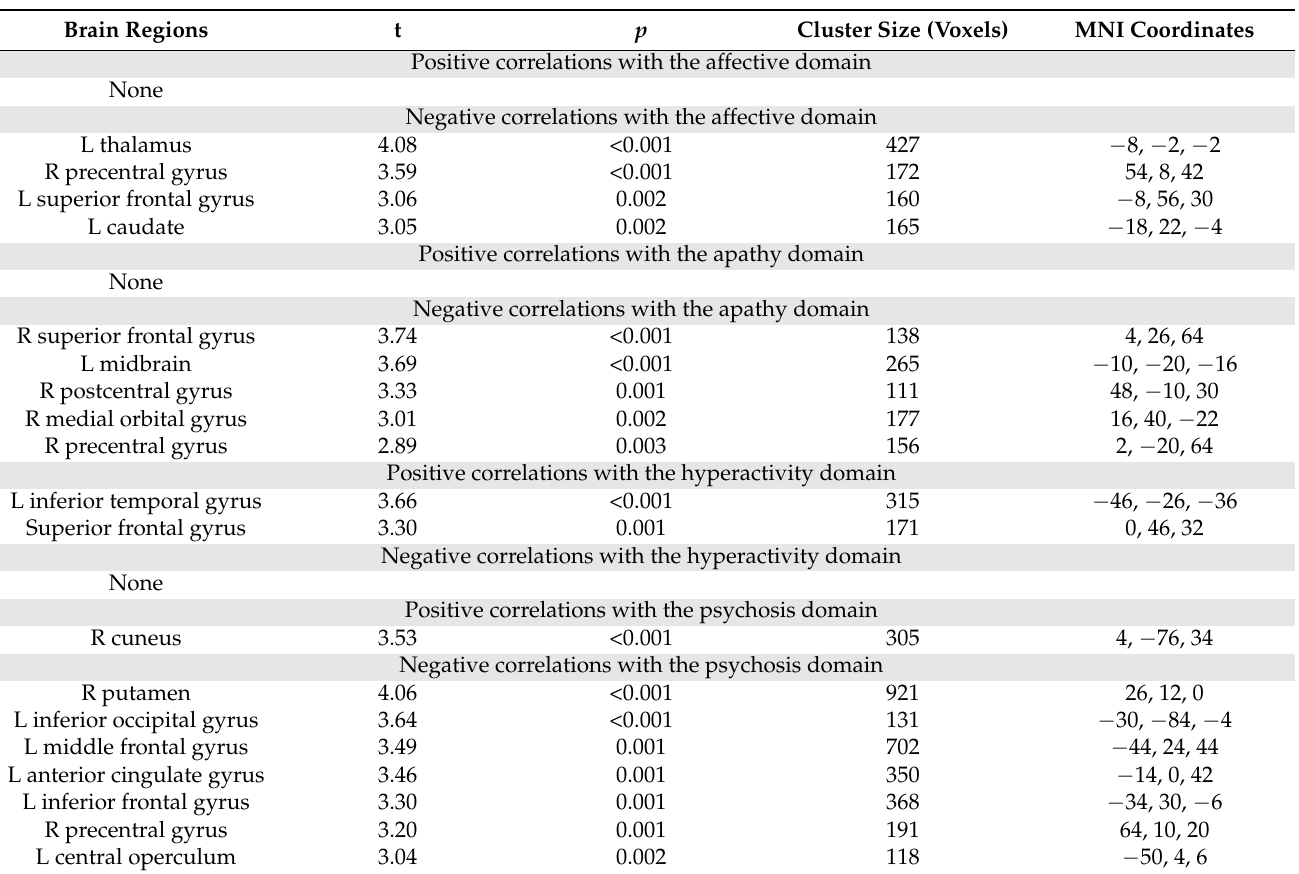
Table 2. Brain regions with significant correlations between regional cerebral blood flow and the neuropsychiatric symptom domains.